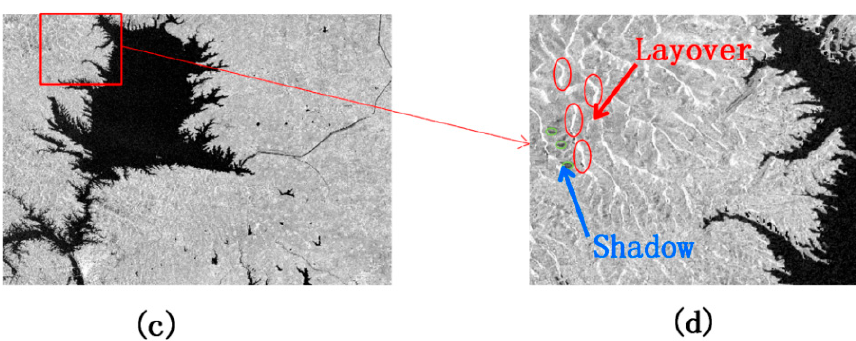
Figure 17. Original and compensated SAR images: ( a ) Original HV polarized Gaofen-3 image; ( b ) part of the enlarged area of ( a ); ( c ) compensated image of ( a ); ( d ) part of the enlarged area of ( c ).